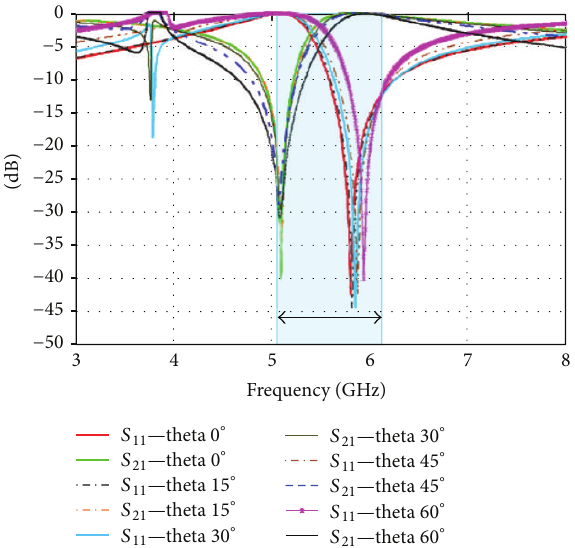
Figure 8: Reflection and transmission coefficients of FL-LHM unit- cell under incident wave at any direction from 0 ∘ to 90 ∘